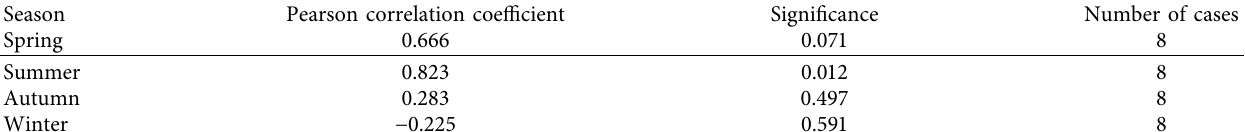
Table 3: Pearson correlation coefficient between natural wind pressure and ventilator air volume.